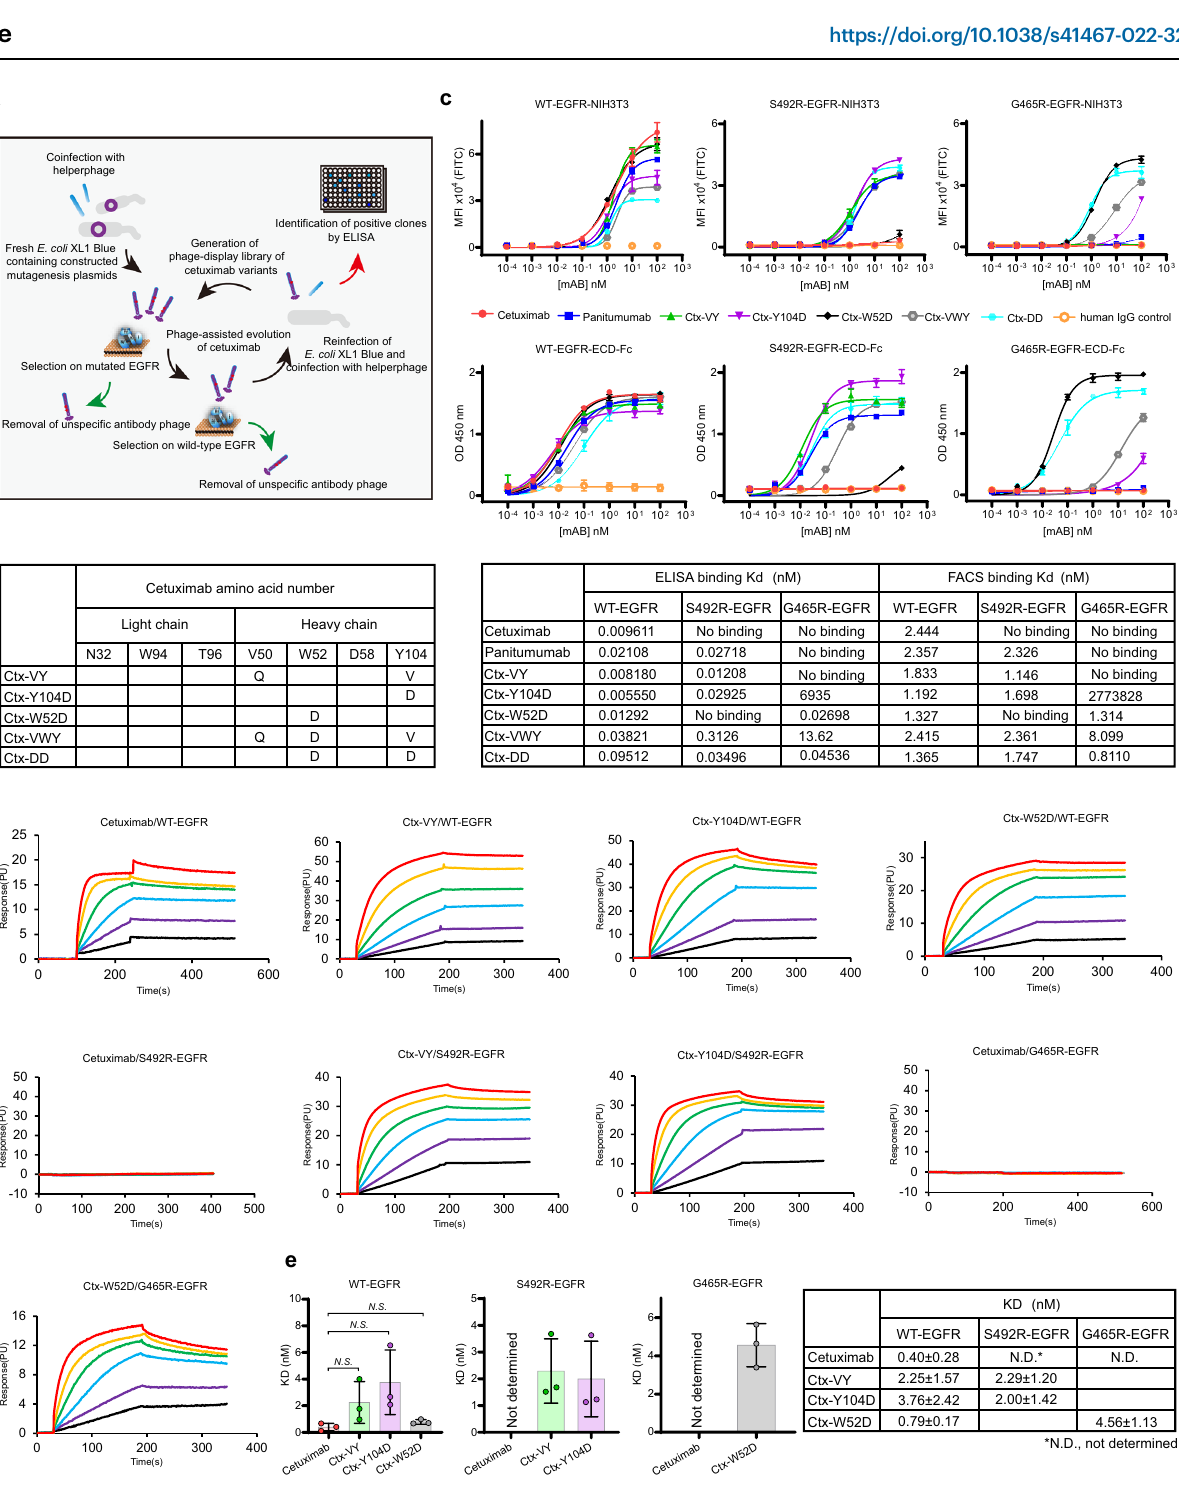
Kd value was calculated using nonlinear regression analysis of a one-site binding hyperbolic equation in GraphPad Prism 8.0 software. d Representative traces of SPR analysis of the binding kinetics of the cetuximab variants with WT-EGFR-ECD- Fc or Mut-EGFR-ECD-Fc. e The determination of dissociation constants (KD) of cetuximab and its variants upon binding with the fusion protein WT-EGFR-ECD-Fc or Mut-EGFR-ECD-Fc. All above assays were performed in triplicate. The bars indi- cate the mean±SD values ( N.S. means not signi fi cant; two-tailed Student ’ s t -test). Source data are provided as a Source Data fi